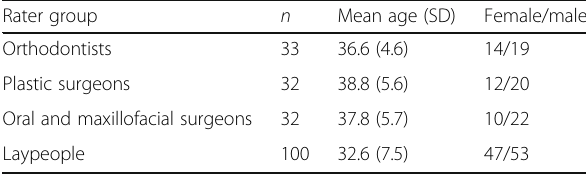
Table 1 Mean age and gender distribution of the rating panels Rater group n